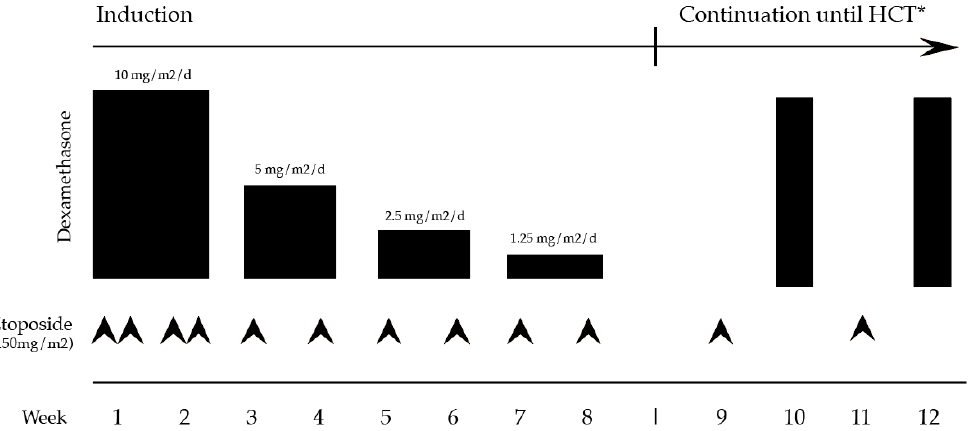
Figure 3. Treatment schematic of the HLH-94 protocol. * After an 8-week induction, continuation therapy is recommended for all pHLH and persistent or reactivated non-pHLH, which consists of alternating etoposide 150 mg/m 2 every other week with dexamethasone 10 mg/m 2 /d for 3 days until HCT. Daily oral cyclosporine A was given in the original HLH-94 protocol during continuation, targeting trough levels of 200 µg/L, though this is often omitted in contemporary regimens. Reproduced with modifications from Henter et al. [53].